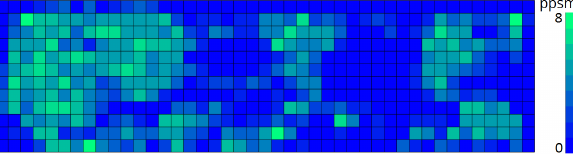
Figure 8. Water surface point density in points per square meter.